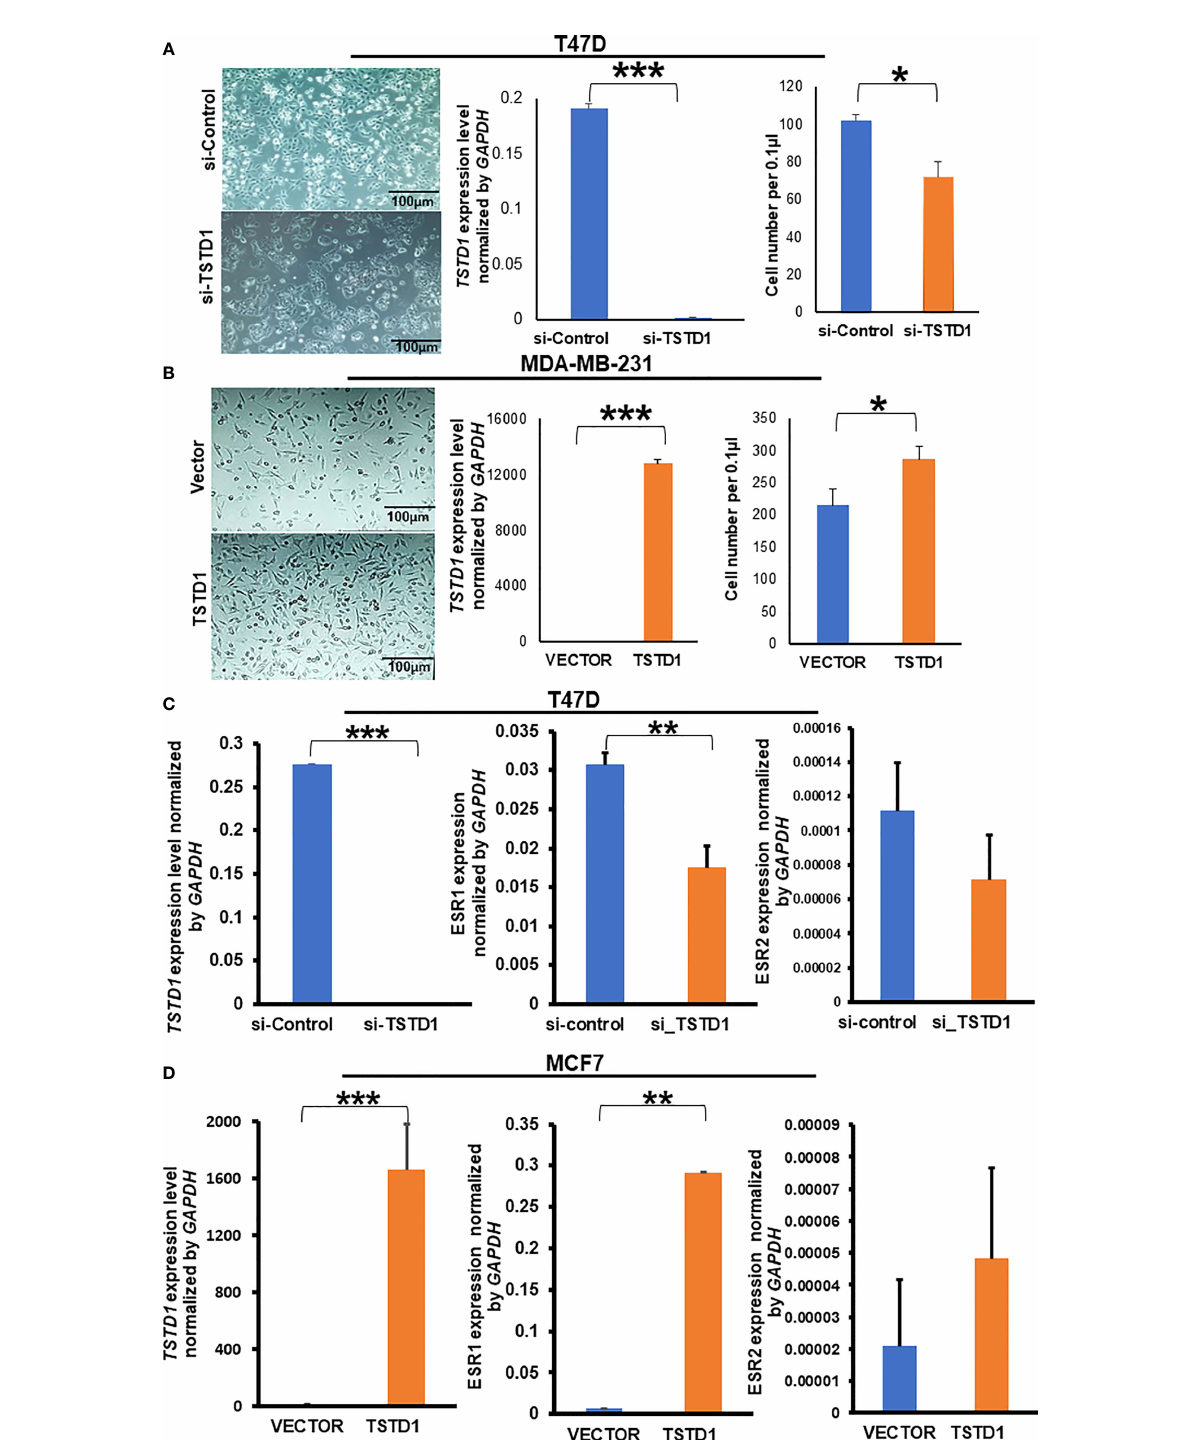
FIGURE 4 TSTD1 expression repressed and induced the proliferation of cancer cell lines and involved in the alteration of ESR1 and ESR2 . GAPDH was used as internal control, (A) Images of T47D breast cancer cell lines after transfection with si-TSTD1 and the relative proliferation of T47D cells, (B) expression of TSTD1 and the relative proliferation of MDA-MB-231 cells after pCMV- TSTD1 plasmid transfection, (C) ESR1 and ESR2 expression after knockdown of TSTD1 in T47D cell line, (D) ESR1 and ESR2 expression after pCMV- TSTD1 plasmid transfection in MCF7 cell line. The data are presented as the mean ± SD, *p ≤ 0.05, **p ≤ 0.01, ***p ≤ 0.001